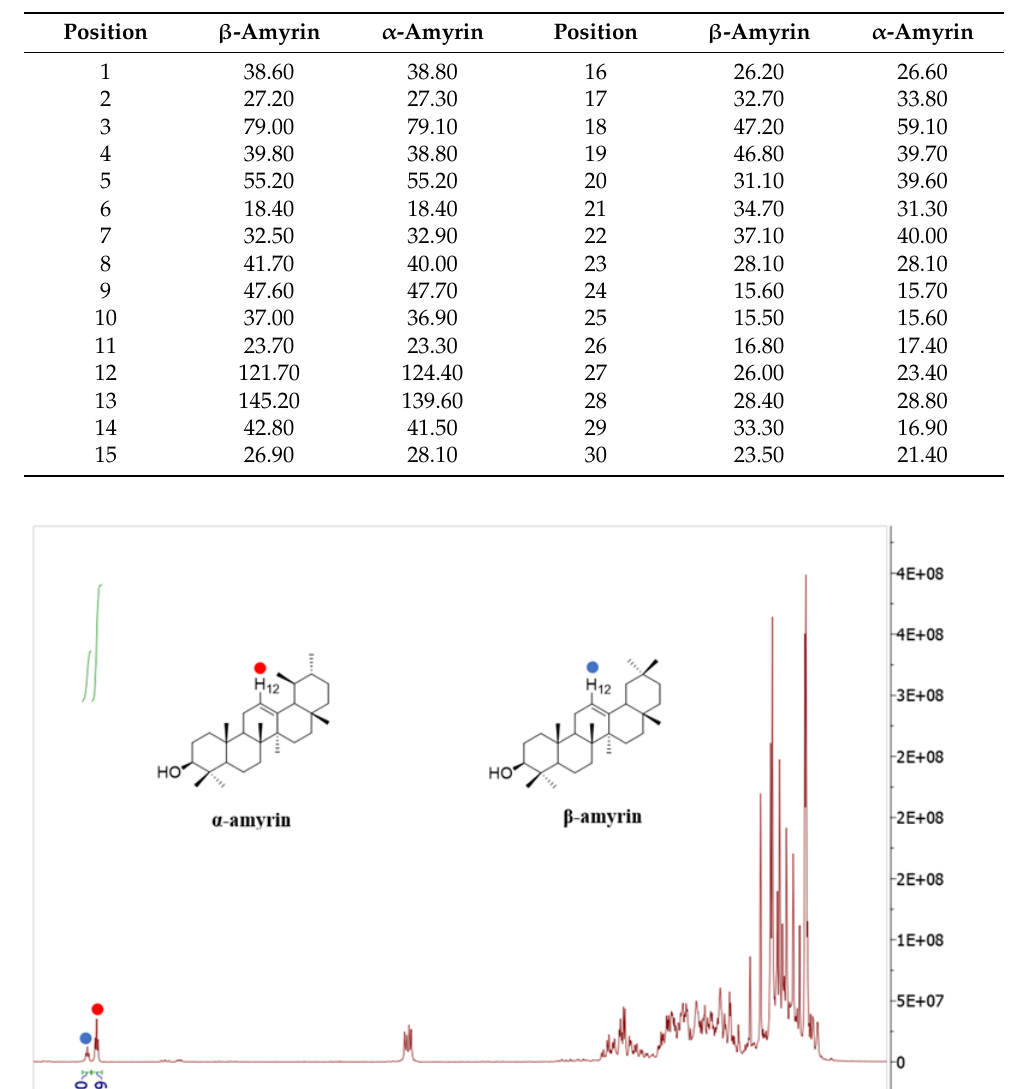
Table 2. 13 C-NMR data for α -amyrin and β -amyrin in CDCl 3 .